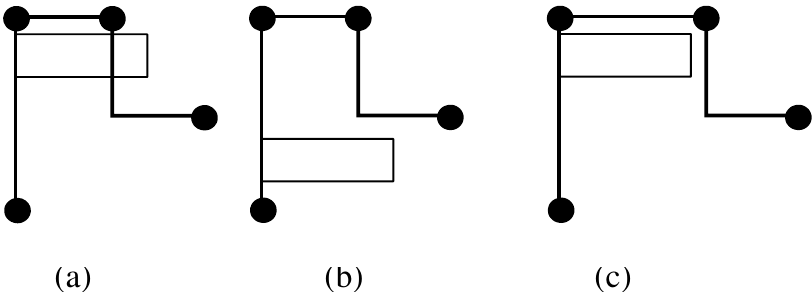
Figure 21. ( a ) An overlapping edge label, which is associated with the source (top) node; ( b ) the label is moved to eliminate overlaps without inserting extra space; ( c ) vertical space has been inserted to eliminate overlaps in order to avoid ambiguity.